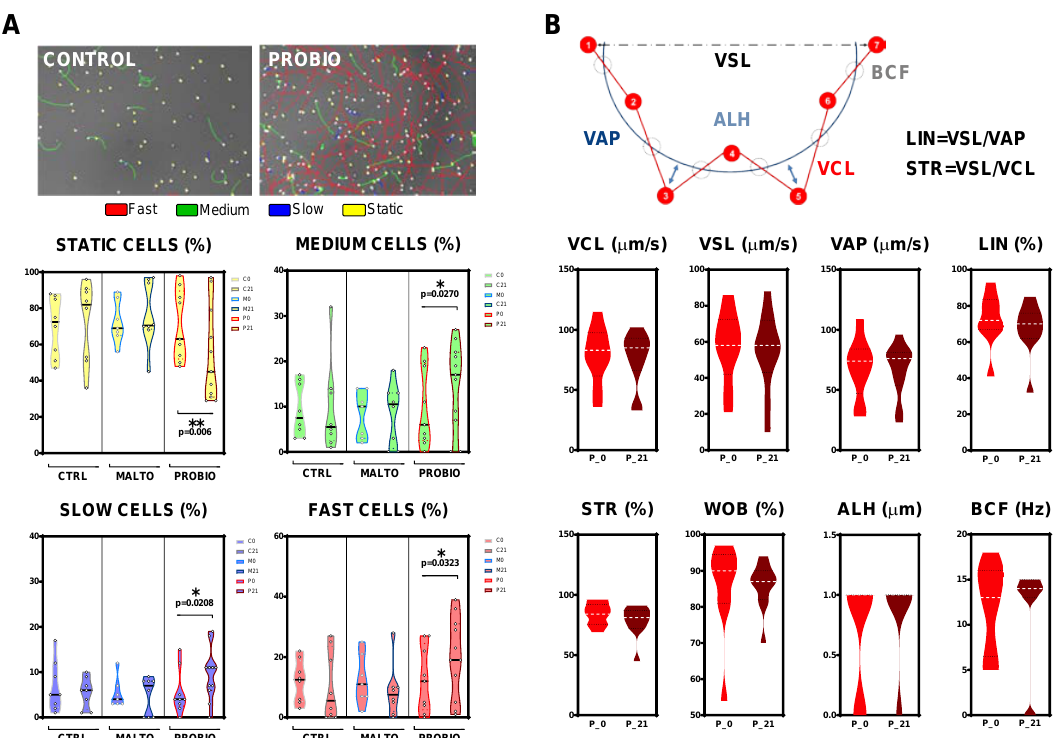
Figure 3. Probiotic mixture supplementation effects on zebrafish sperm kinematics after a cycle of spermatogenesis exposure. ( A ) Sperm subpopulations within the motile population according to speed parameters before and after the experiment for each group. ( B ) Detailed sperm kinetics rendered by the CASA system for the PROBIO group. Asterisks show statistically significant differences; * ( p < 0.0500). Abbreviations: VCL—curvilinear velocity, VSL—straight line velocity, VAP—average path velocity, LIN—linearity of the curvilinear path, STR—straightness, WOB—wobble, ALH—amplitude of the lateral head displacement, BCF—beat cross frequency.